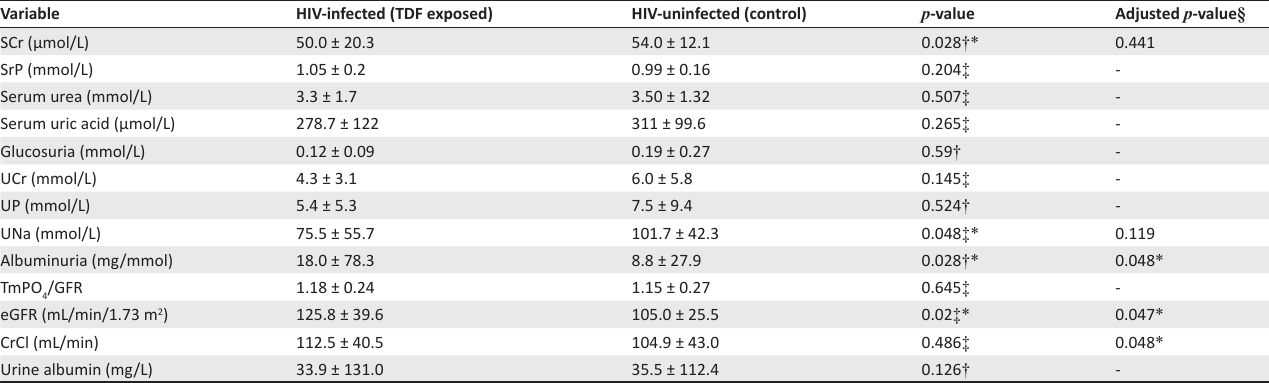
TABLE 2: Comparison between mean values (and standard deviations) of renal function markers in HIV-infected ( n = 30) and uninfected women ( n = 30). Variable HIV-infected (TDF